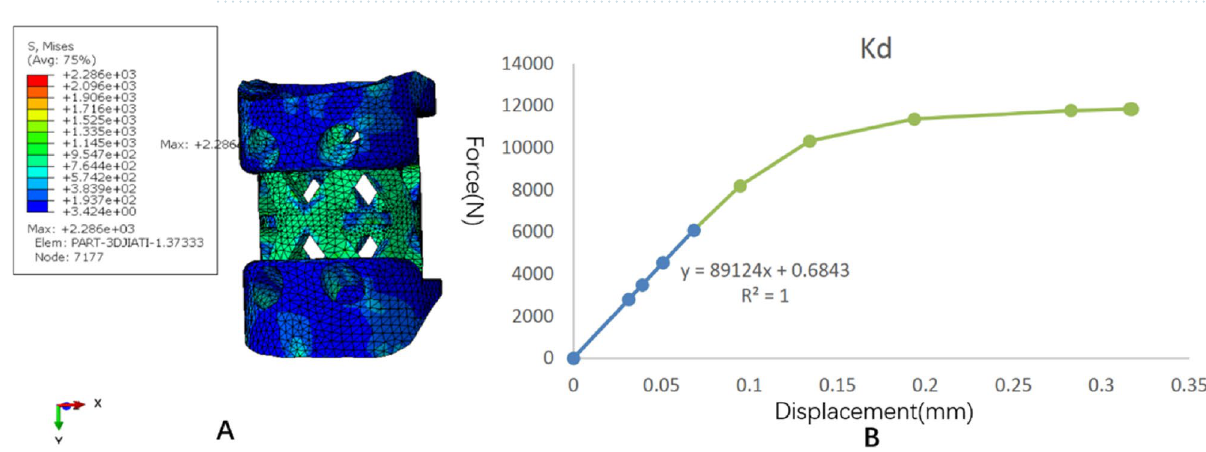
Figure 7. The stress distribution and the force displacement curve of the novel titanium mesh cage (NTMC)’s Kd. ( A ) The stress distribution diagram; ( B ) the force displacement curve (Abaqus 2016, SIMULIA Co,